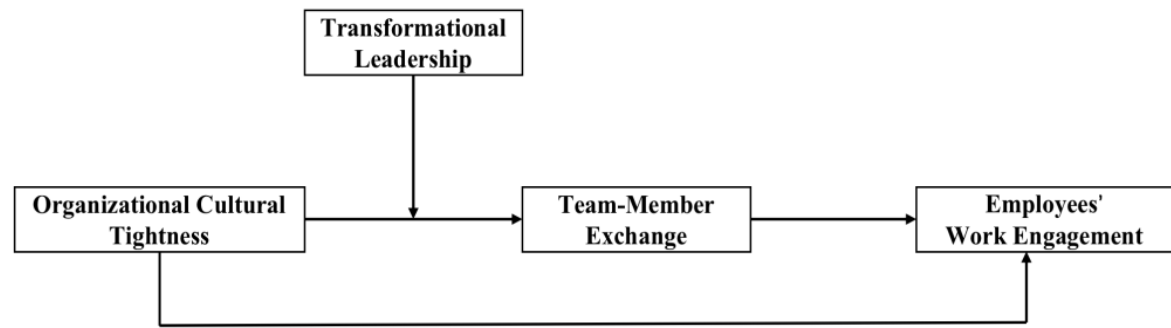
Figure 1. Conceptual